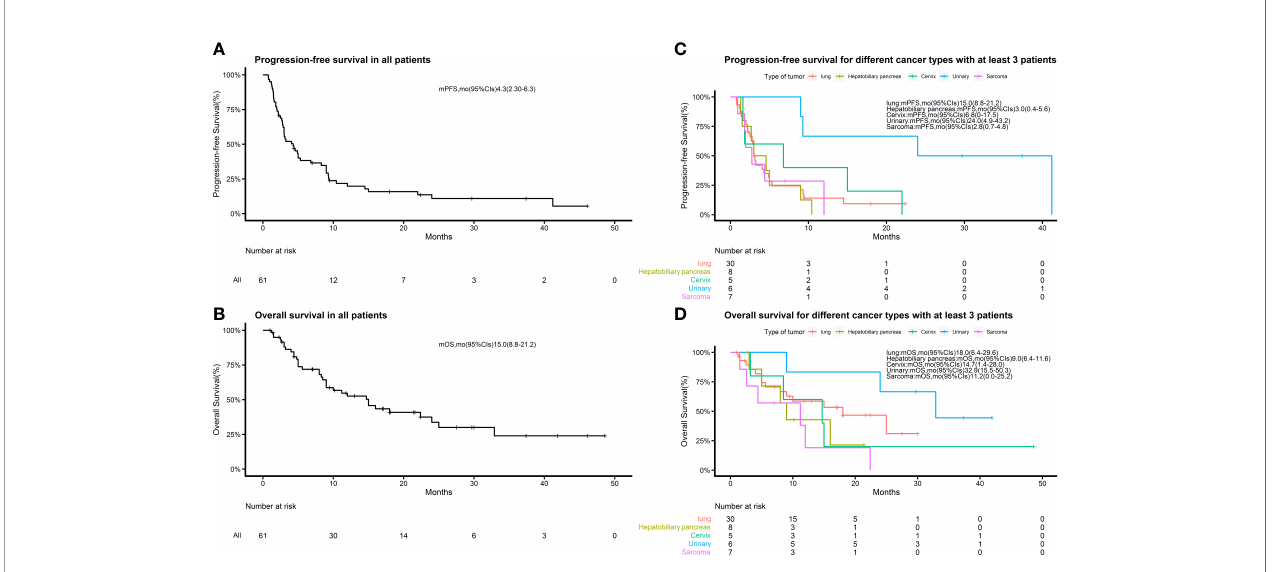
FIGURE 1 | Kaplan – Meier estimates of progression-free survival and overall survival. (A) Kaplan – Meier estimates of progression-free survival in all patients; (B) Kaplan – Meier estimates of overall survival in all patients. (C) Kaplan – Meier estimates of progression-free survival for different cancer types with at least 3 patients in each group. (D) Kaplan – Meier estimates of overall survival in the groups described in (C) .